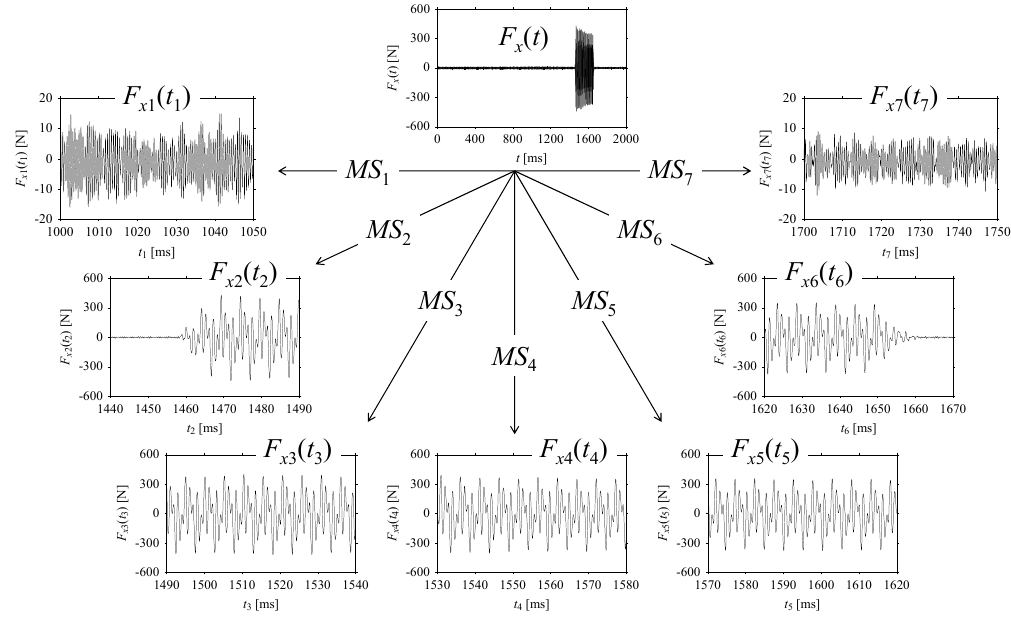
Figure 15. Sampling F x ( t ) based on machining situations ( MS ). Nevertheless, the sampled fragments ( F x 1 ( t 1 ), . . . , F x 7 ( t 7 )) are analyzed in the fre- ( MS 1 , . . . , MS 7